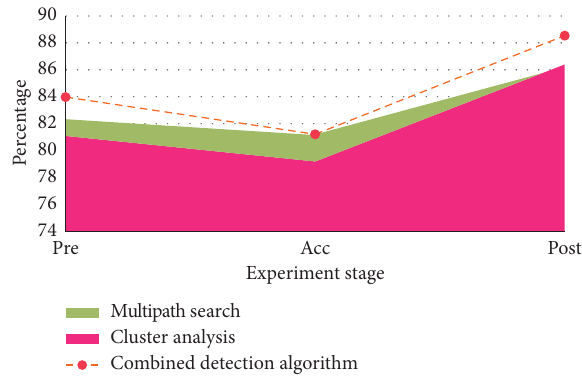
Figure 8: The result of 4 instruments (%).